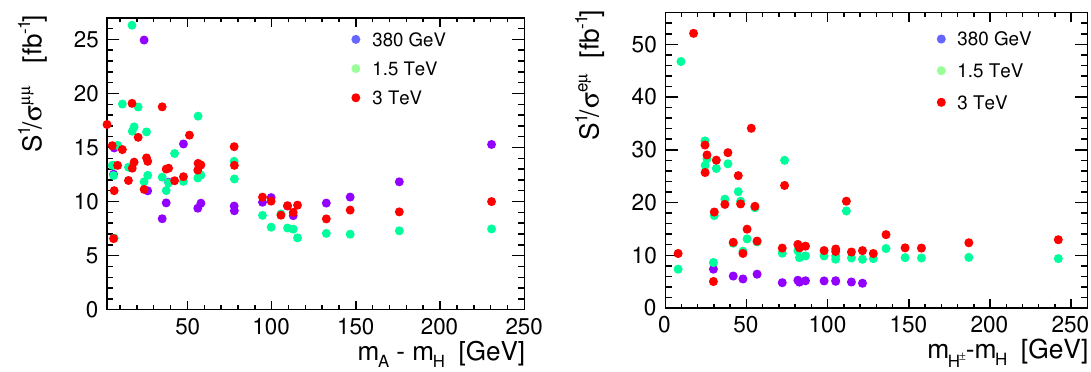
Figure 12 . Ratio of the expected signi(cid:12)cance scaled to the integrated luminosity of 1 ab (cid:0) 1 to the signal cross-section in the considered channel: (left) with two muons in the (cid:12)nal state ( (cid:22) + (cid:22) (cid:0) ) and (right) with electron-muon pair production ( e + (cid:22) (cid:0) or e (cid:0) (cid:22) + ), as a function of the scalar